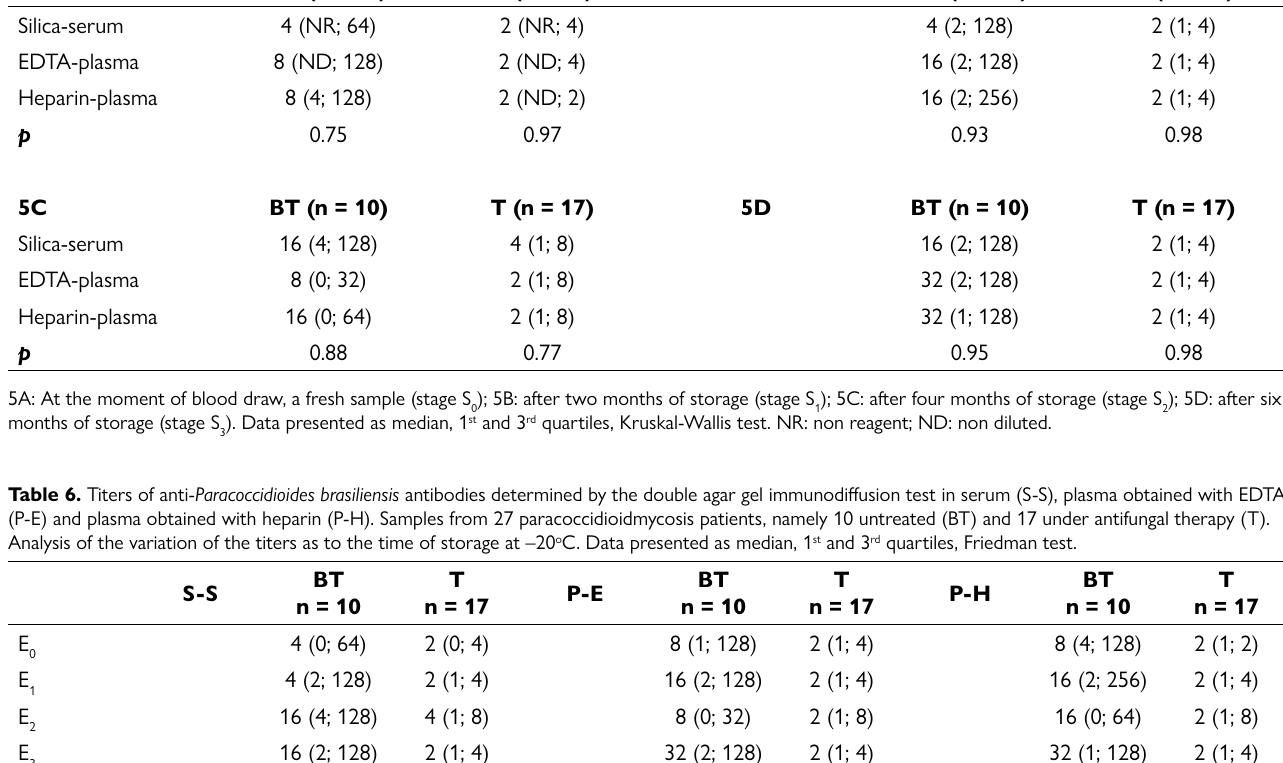
Table 5. Serum and plasma titers of anti- Paracoccidioides brasiliensis antibodies determined by the double agar gel immunodiffusion test in blood samples drawn from 27 paracoccidioidomycosis patients, in specific tubes. Comparison of the titers observed in different blood matrices, in 10 patients at admission, before treatment (BT), and in 17 patients under antifungal treatment (T), at the moment of blood draw and after two to six months of storage at –20 o C